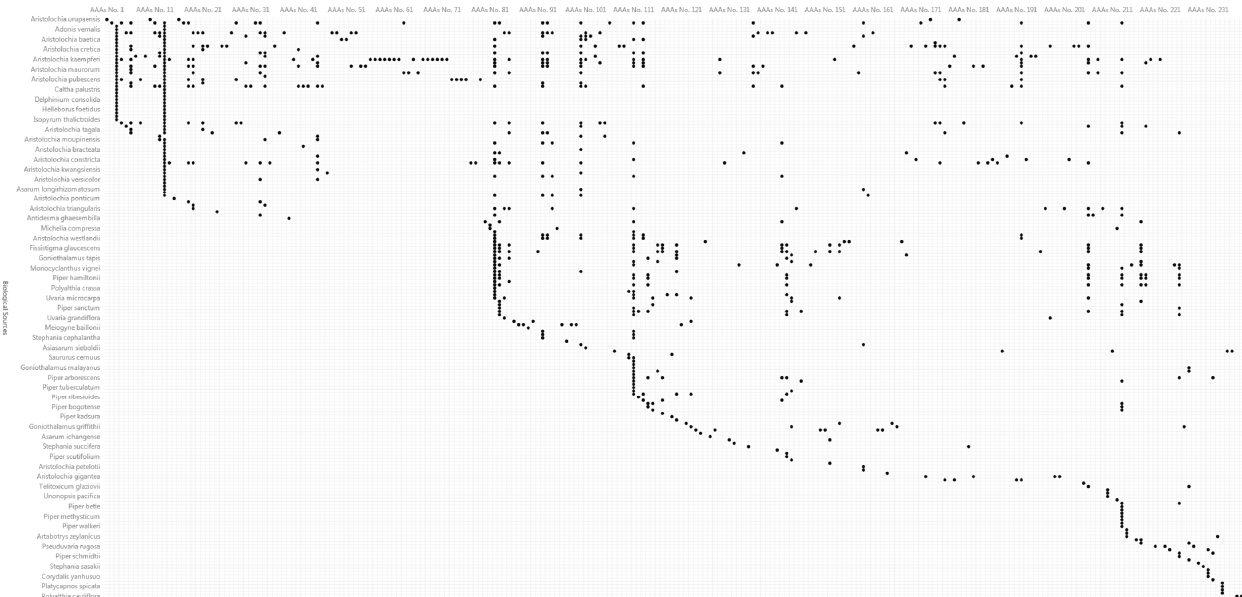
Figure 6. Relationship matrix analysis of aristolochic acid analogues and their biological sources. High-resolution image file of this figure can be found in Supplementary Materials as Figure S4.